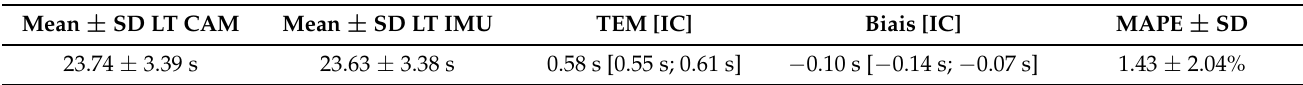
Table 7. Statistical agreement between lap times computed by stopwatch and gold standard video (n = 870